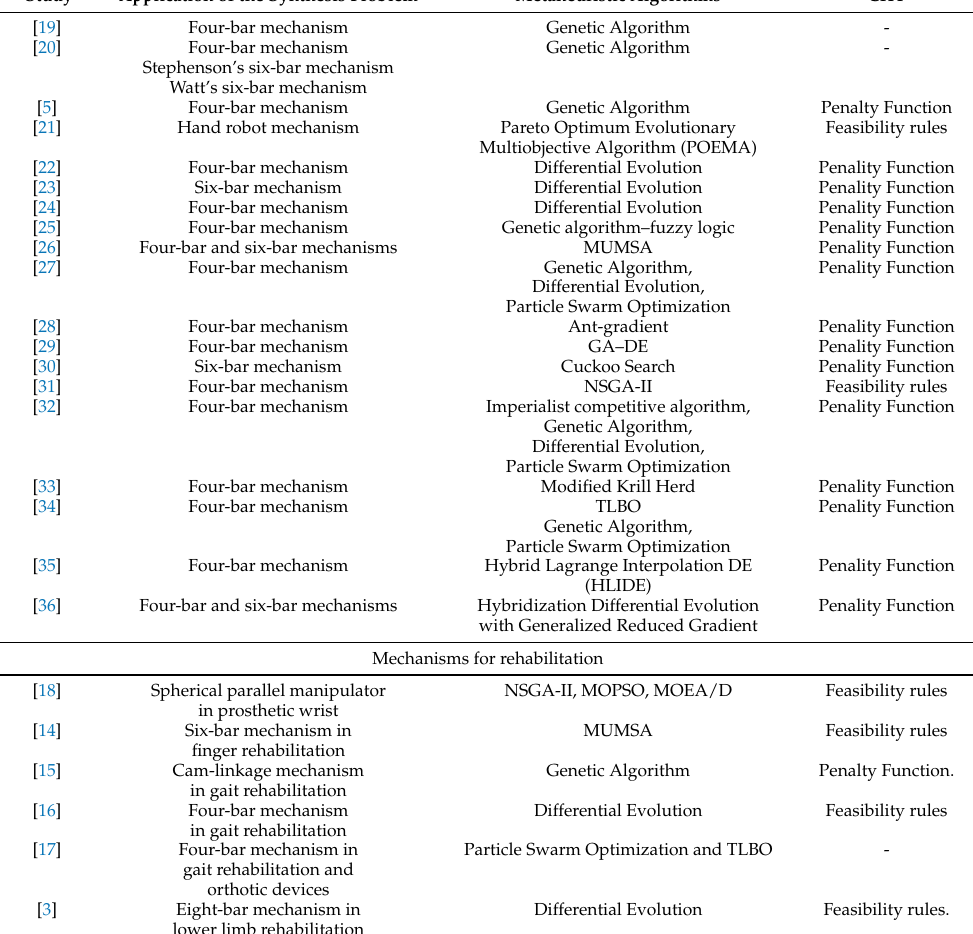
Table 1. Summary of investigations tackling metaheuristic algorithms in the kinematic synthesis problem. “-” indicates that the use of CHT is not